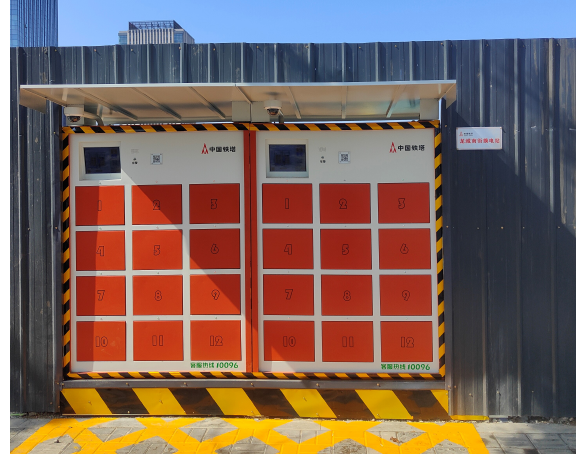
Figure 6. Battery swap